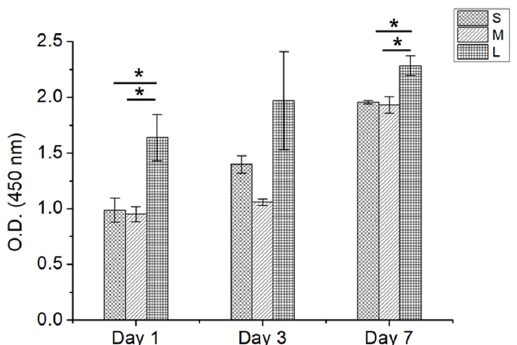
Figure 4. HDF cell proliferation results collected on highly porous PCL microspheres with various pore sizes after cell attachment for 1 week (* p < 0.05).